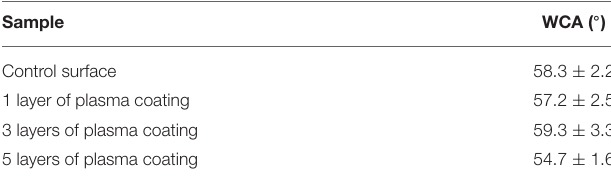
TABLE 5 | Effect of plasma deposition on water contact angle (WCA) values of polystyrene microplate